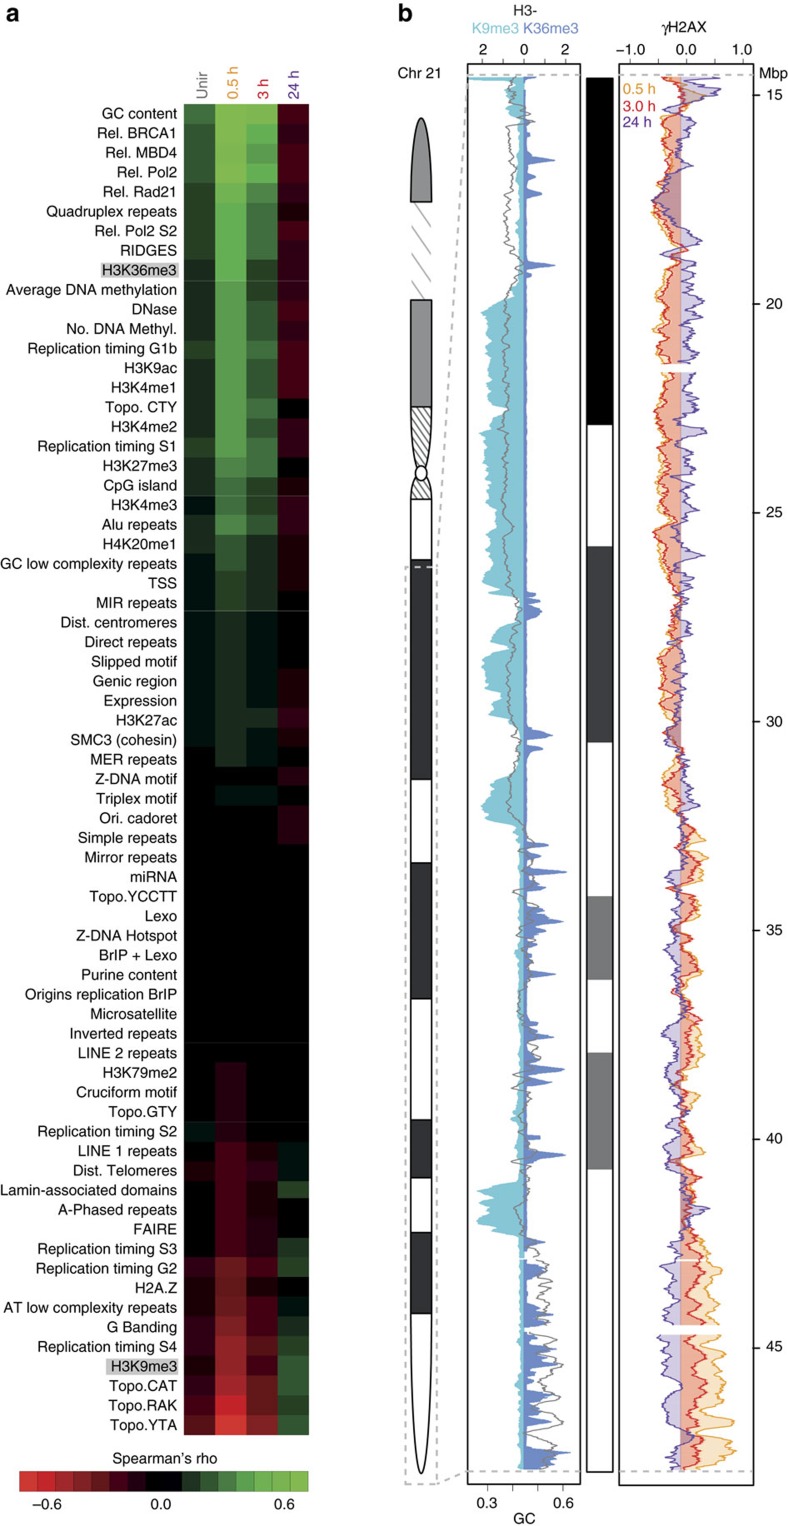
Temporal correlation of γH2AX ChIP-Seq signal and genomic features.(a) Genome-wide correlation between ChIP-Seq γH2AX profiles and genomic features, before and during DDR. Spearman's ρ correlation coefficient is calculated between 10 kb-binned γH2AX profiles and the genomic features (Supplementary Table 3), and colour-coded from red (anti-correlation) to green (correlation). All genomic features are ordered decreasingly, according to the highest correlation value (γH2AX and GC, 0.5 h: 0.81). For all correlations: P<<2.2 × 10−16. (b) Exemplary ChIP-Seq γH2AX profile on chromosome 21. (left) H3K9me3, H3K36me3 and GC content (grey line); (right) γH2AX levels during DDR.